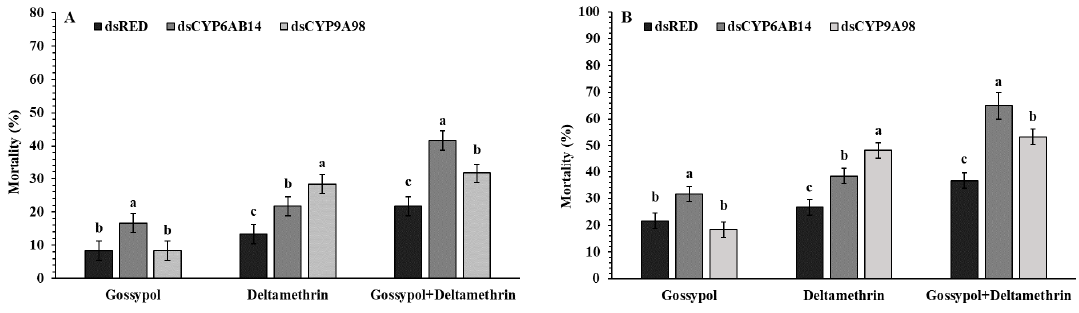
Figure 4. Single e ff ects of dsCYPAB14 and dsCYPA98 feeding on the susceptible of fourth instar S. exigua larvae. Following the droplet-feeding with dsCYPAB14 + dsCYPA98 or dsRED for 24 h the exposed larvae were transferred individually into 12-oriface tissue culture plate containing artificial diets supplemented with 0.1 % gossypol, LC 50 concentration of deltamethrin 0.887mg / L for 48 ( A ) and 72 h ( B ) or 0.1 % gossypol for 24 h followed by deltamethrin for 48 ( A ) and 72 h ( B ). Data shown are means ± SE derived from three biological replicates. Di ff erent letters above bars indicate significant di ff erences ( p < 0.05) according to the Tukey HSD test.